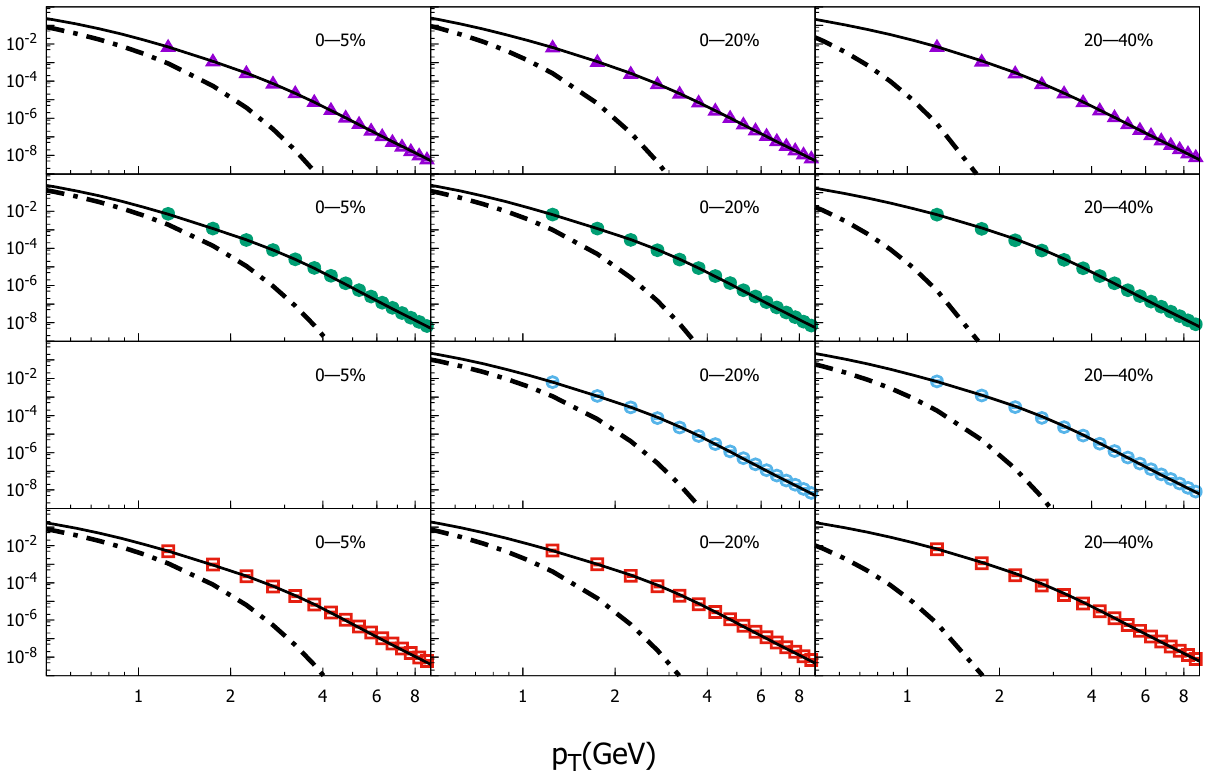
Figure 2. The yield dN xA / d 2 p T dy for xA collisions divided by the number of binary collisions, N coll , as a function of transverse momentum. Data from PHENIX Collaboration [30] at small transverse momentum region. Different projectile species and three more central classes of centrality are presented. The dot-dashed lines represent the contribution of the particle produced in thermal equilibrium, and the solid lines correspond to the sum given by Equation (7). See text for details. Finally, the quantity dN ch / d η is studied, assuming that the charged hadron multiplicity ( N ch ) is given predominantly by pions. Accordingly, the integrated pion spectra (after transformation y → η ) can be compared to the measured multiplicities. A comparison between predictions and the PHENIX data [77] is presented in Figure 4. In the figures, the black “ × ” symbols represent the results, and for better viewing, the dot-dashed lines correspond to their linear regression for each projectile species. For N coll (cid:38) 10, the ratio dN d η / N R xA at small p T ; namely, there is a ch / coll follows the same pattern observed for scaling that is less steep on N coll . In the intermediate region, dN ch / d η / N coll is practically constant in terms of N coll . In [79], an analysis of the energy loss parameter, δ p T , for